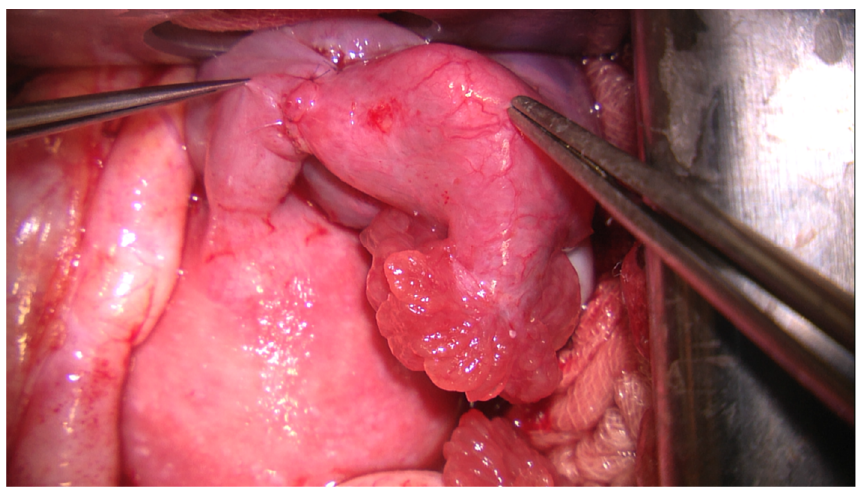
Figure 2. The complete restoration of the tubal anatomy, suture of the peritoneal serosa after the termino-terminal anastomosis (zoom × 10).